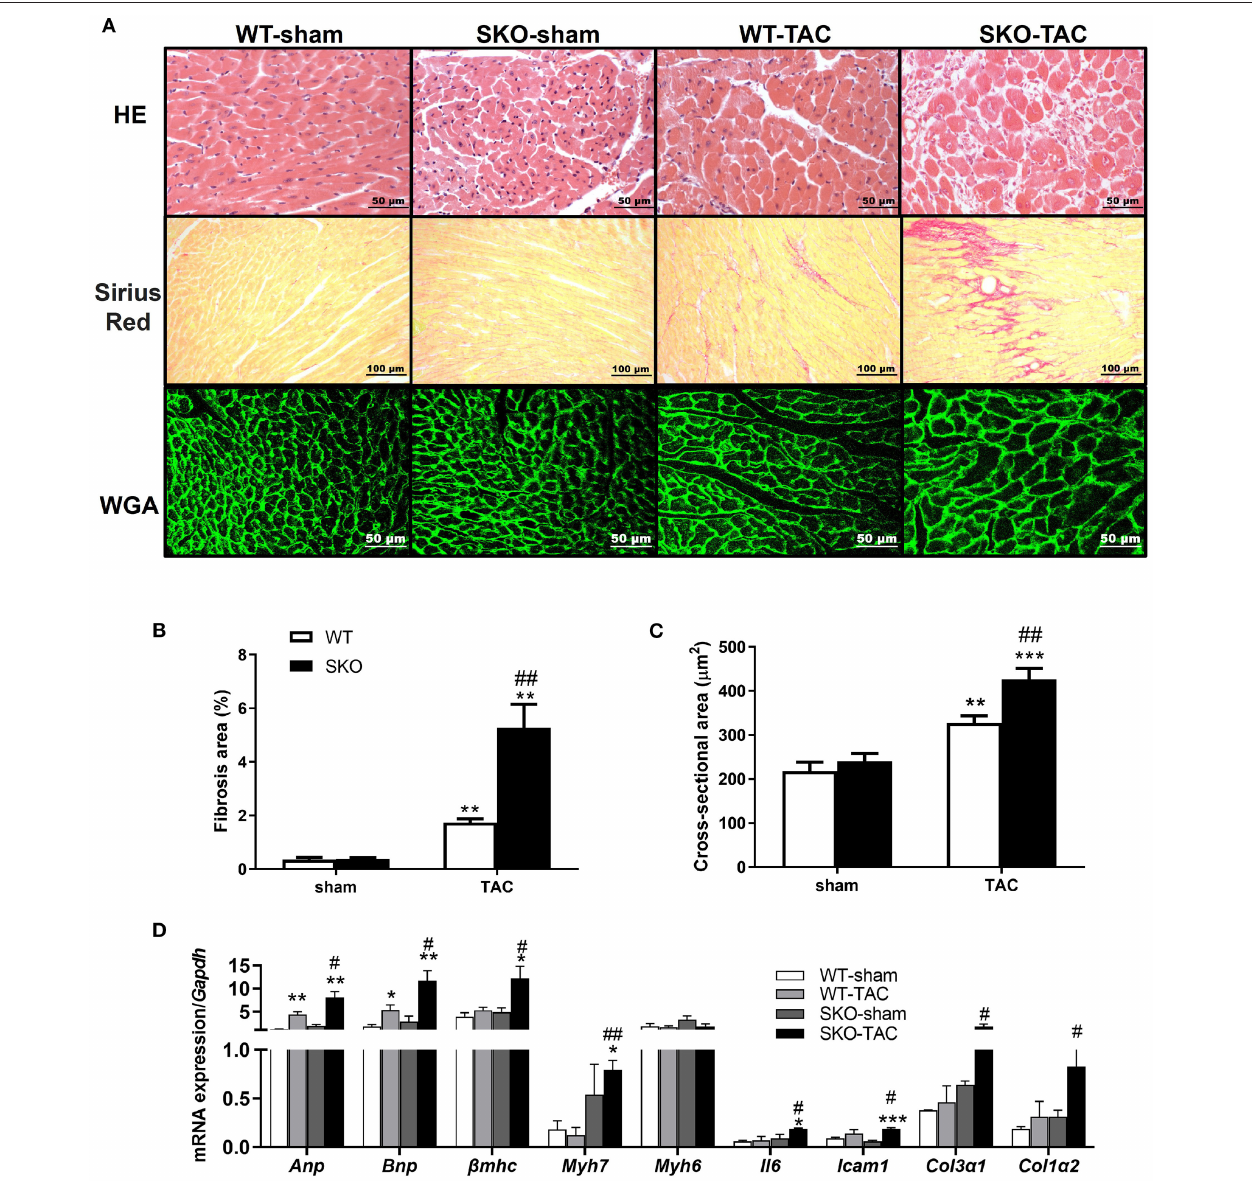
FIGURE 3 | Seipin deficiency accelerated cardiomyocyte hypertrophy and inflammation and fibrosis in the heart after TAC. (A) Hematoxylin-eosin (HE), Sirius red and wheat germ agglutinin (WGA) staining of the heart cross-section; (B) Percentage of fibrosis area in heart tissue by Sirius red staining; (C) Quantification of cardiomyocyte cross-sectional area by WGA staining; (D) mRNA expression levels of Anp , Bnp, β mhc, Myh7, Myh6, Il6, Icam1, Col3 α 1, and Col1 α 2 . * P < 0.05, ** P < 0.01, *** P < 0.001, effect of TAC; # P < 0.05, ## P < 0.01, effect of genotype. WT, Wild-type; SKO, Seipin knockout; TAC, transverse aortic constriction.